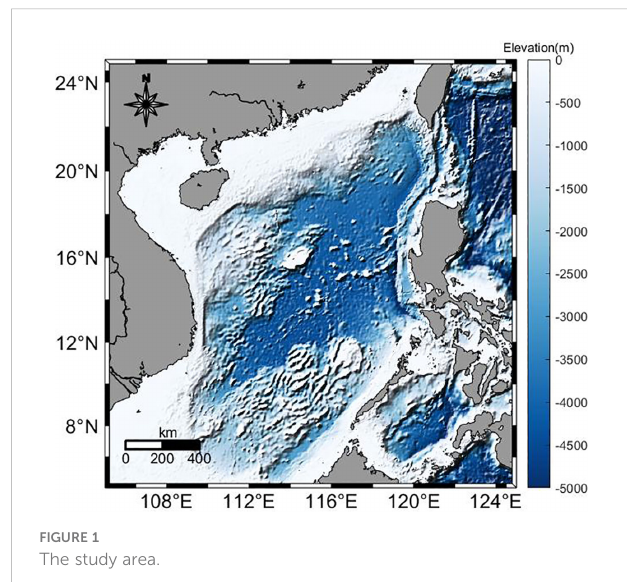
FIGURE 1 The study